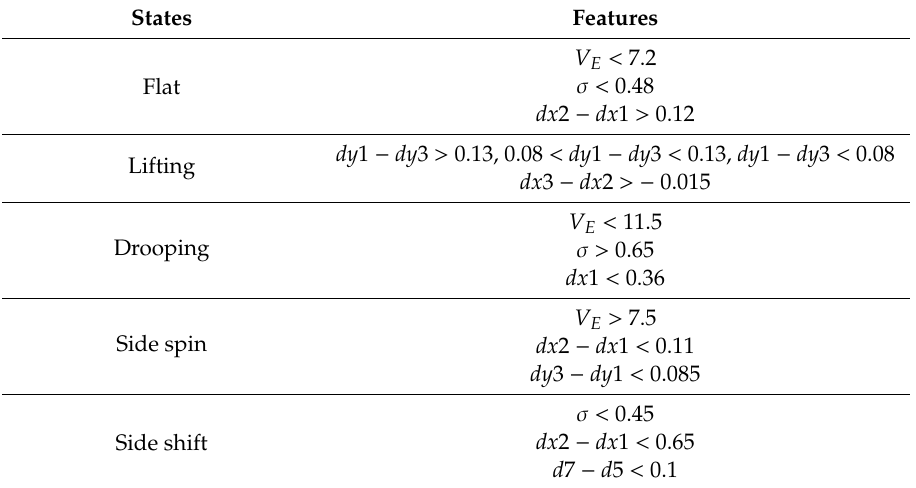
Table 2. Hand posture